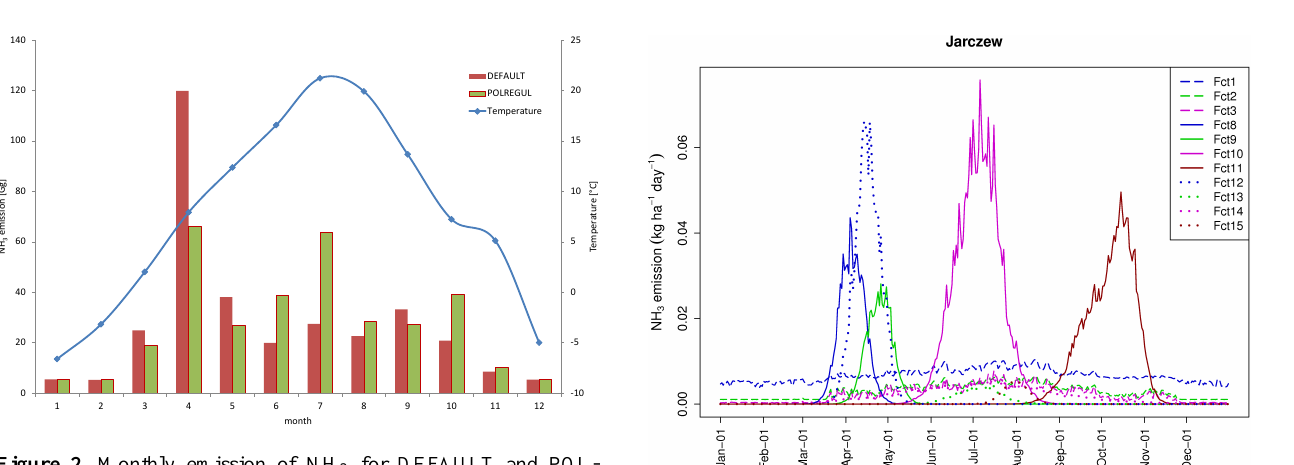
Figure 2. Monthly emission of NH 3 for DEFAULT and POL- REGUL run and average temperature in 2010.